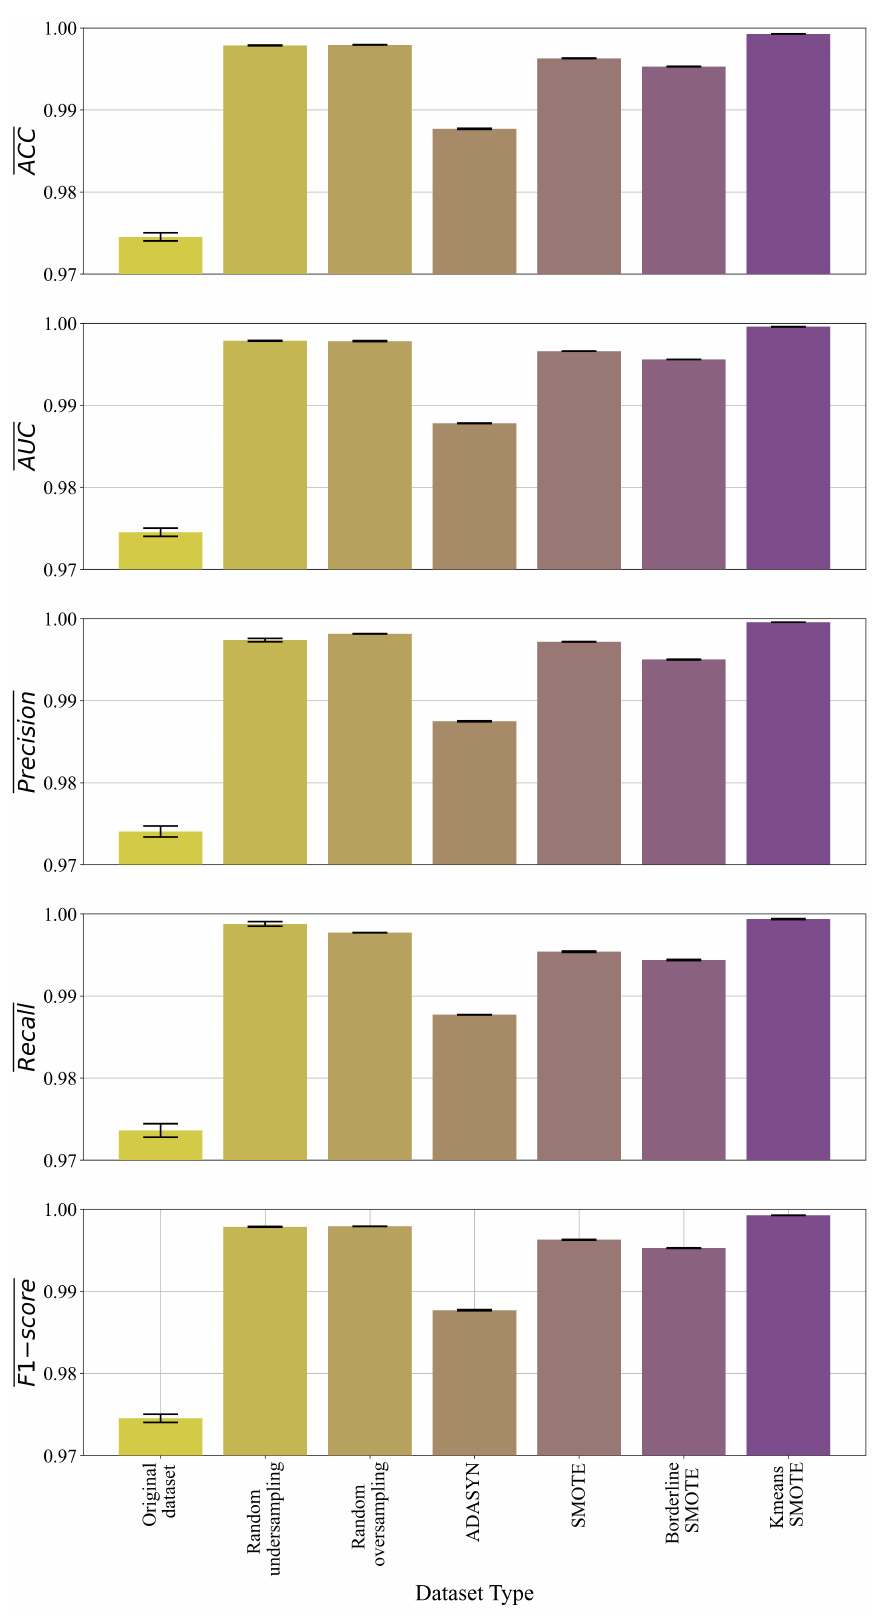
Figure 6. The mean ACC , AUC , precision, recall, and F1-score values achieved with GPSC algorithm on each dataset variation (Standard deviation is presented in form of error